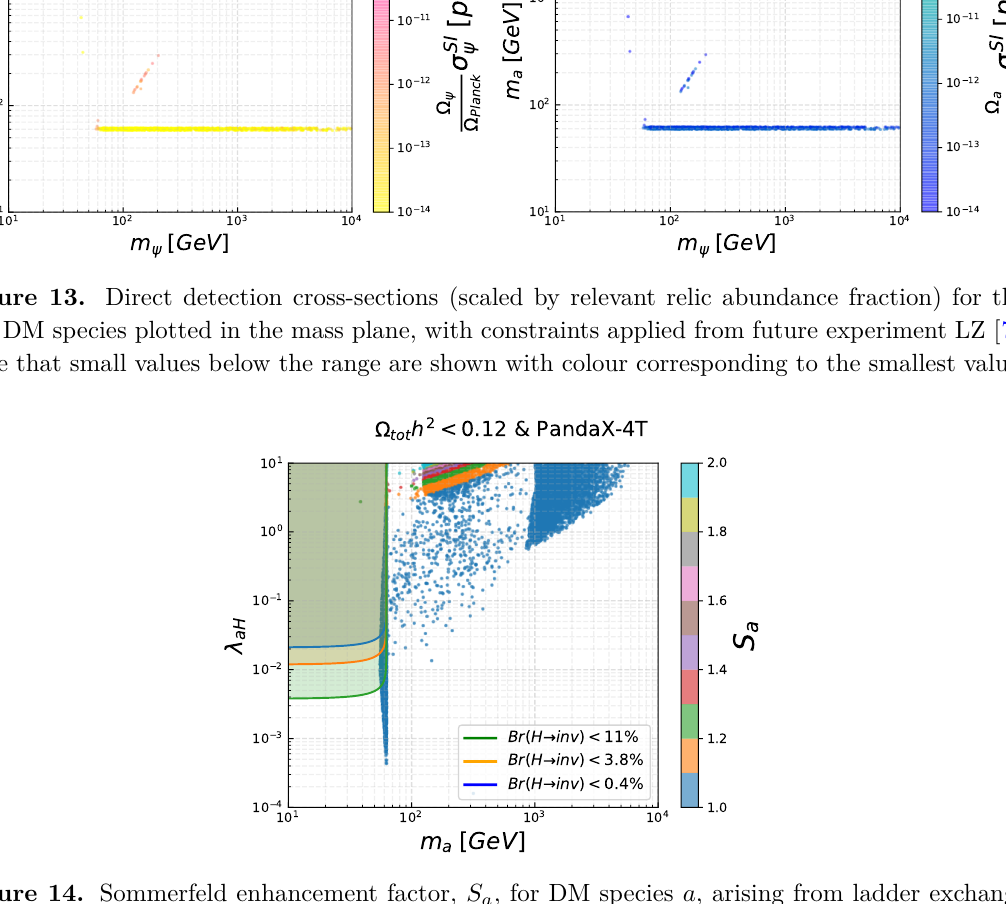
Figure 14. Sommerfeld enhancement factor, S a , for DM species a , arising from ladder exchange of Higgs